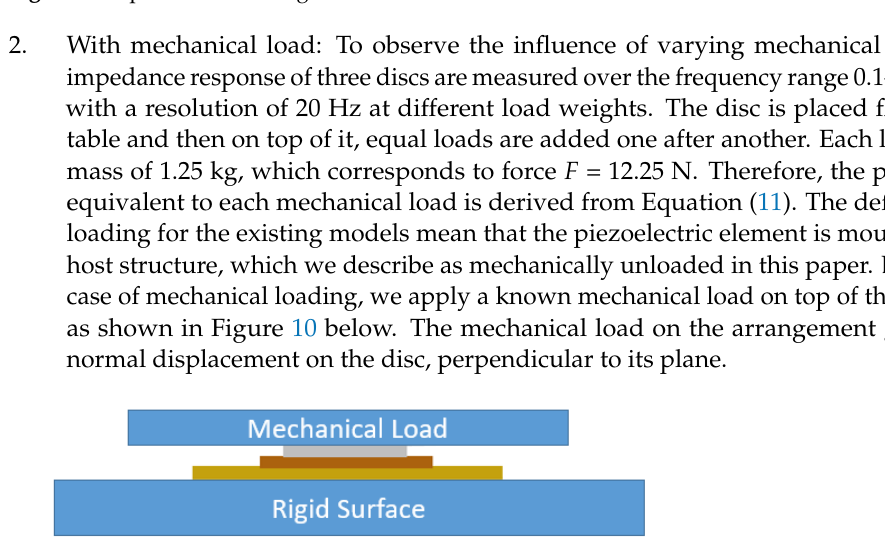
Figure 9. Experimental arrangement for mechanical unload.